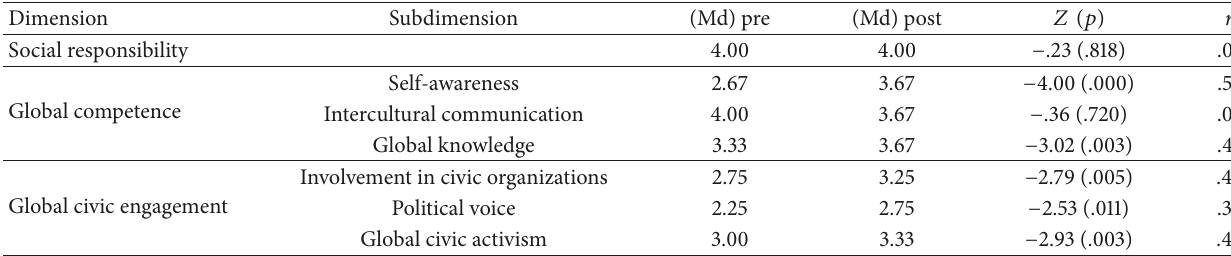
Table 7: Pre- and posttest differences on the Global Citizenship Scale (GCS), 𝑁 = 25